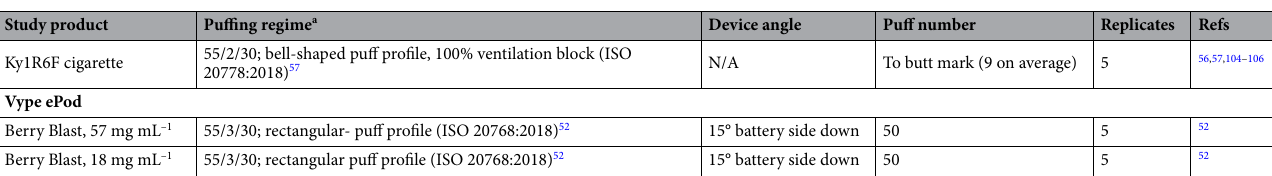
Table 6. Emissions testing parameters for the reference cigarette and the e-cigarette e-liquids. a Puffing regime: volume (mL)/puff duration (s)/puff frequency